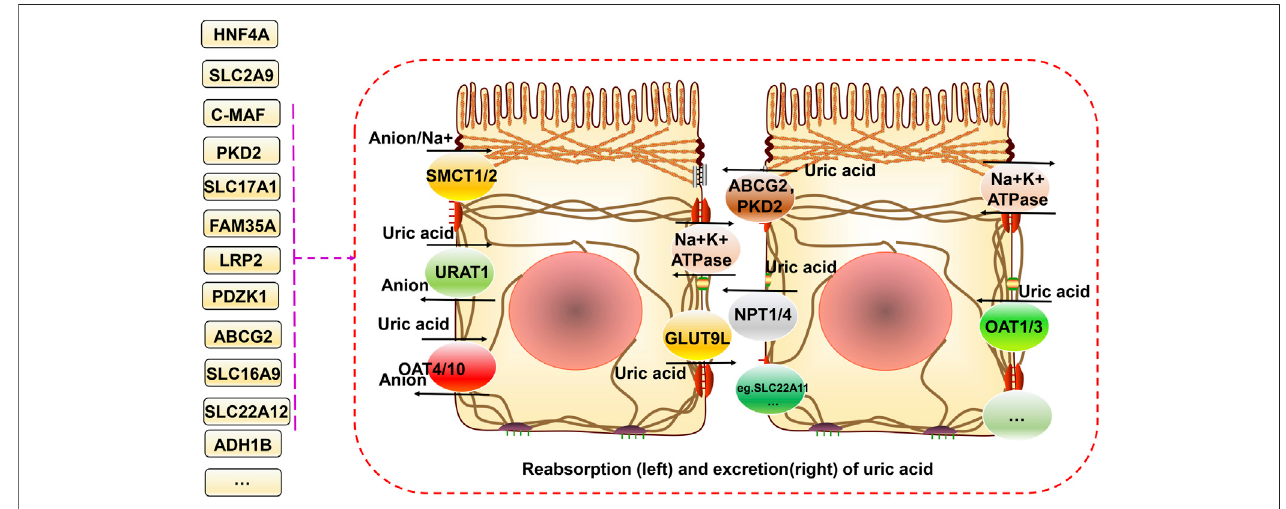
FIGURE 1 | Relationship between gene variants and reabsorption and excretion of uric acid in hyperuricemia and gout. Uric acid is reabsorbed and secreted into theproximaltubulesofthekidneys.URAT1,GLUT9(alsoknownasGLUT9L),OAT4,andOAT10areresponsibleforitsreabsorption.ABCG2,ABCC4,NPT1,andNPT4 mediate uric acid excretion. The balance between reabsorption and secretion is related to uric acid homeostasis. In addition, SMCT1/2 proteins can regulate ion concentrations both inside and outside the cell. Different gene variants have different effects on these processes.